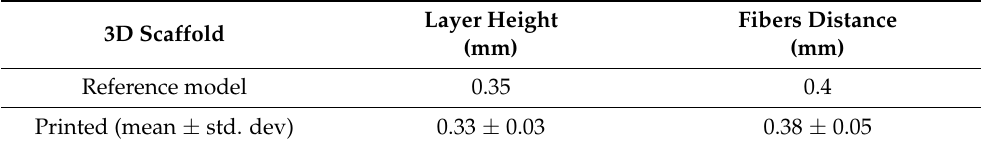
Table 4. Coprinting of PCL with an alginate hydrogel containing MSC secretome. Comparison between dimensions of the 3D model and 3D-printed PCL scaffolds (measure from SEM images, n =